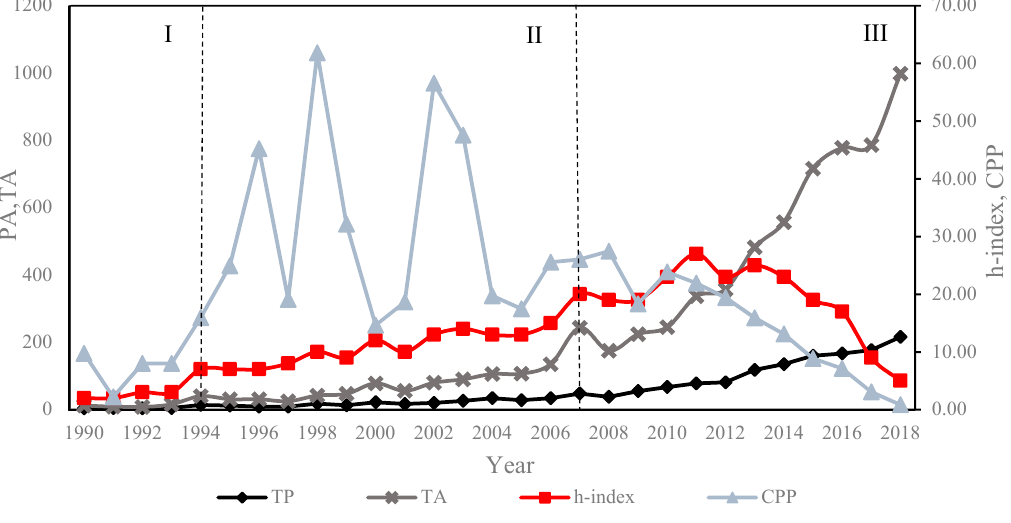
Figure 1. The line chart of the changes in annual TP, TA, h-index and CPP. TP, Total Publications; TA, Total Authors; CPP, Citations Per Paper.